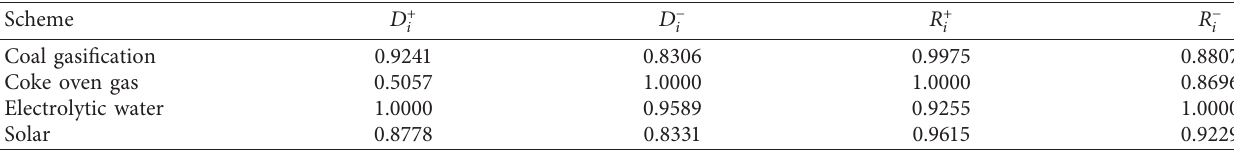
Table 3: Dimensionless processing results.